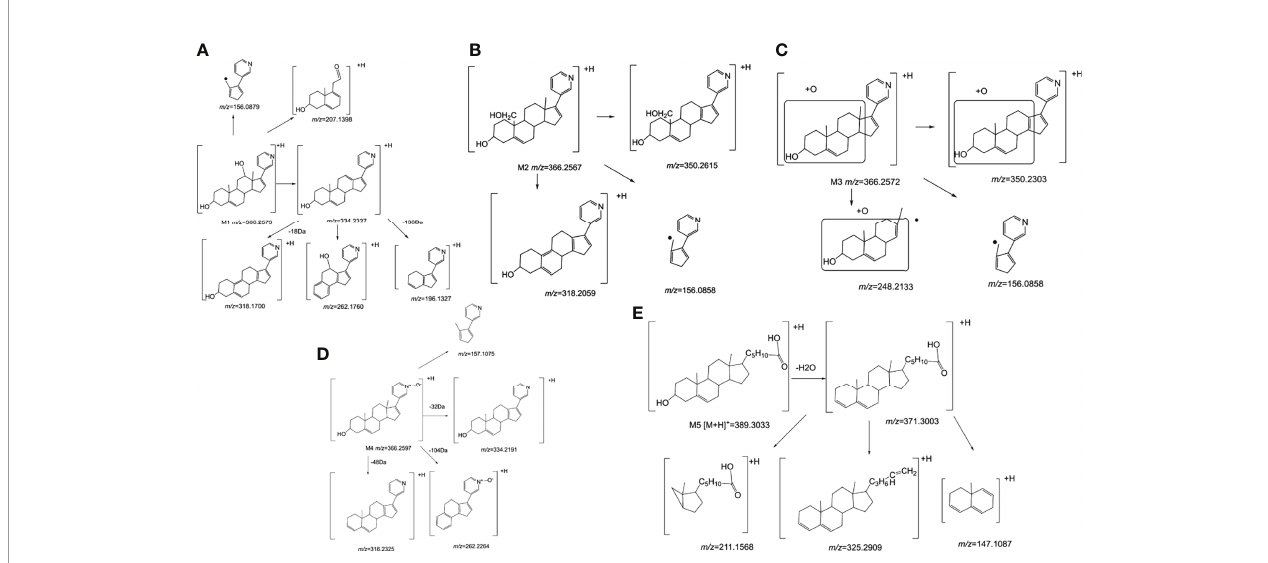
FIGURE 6 | The mass spectrometry fragmentation rule of Abiraterone metabolites. (A) The mass spectrometry fragmentation rule of Abiraterone metabolite M1. (B) The mass spectrometry fragmentation rule of Abiraterone metabolite M2. (C) The mass spectrometry fragmentation rule of Abiraterone metabolite M3. (D) The mass spectrometry fragmentation rule of Abiraterone metabolite M4(Abiraterone N-Oxide). (E) The mass spectrometry fragmentation rule of Abiraterone metabolite